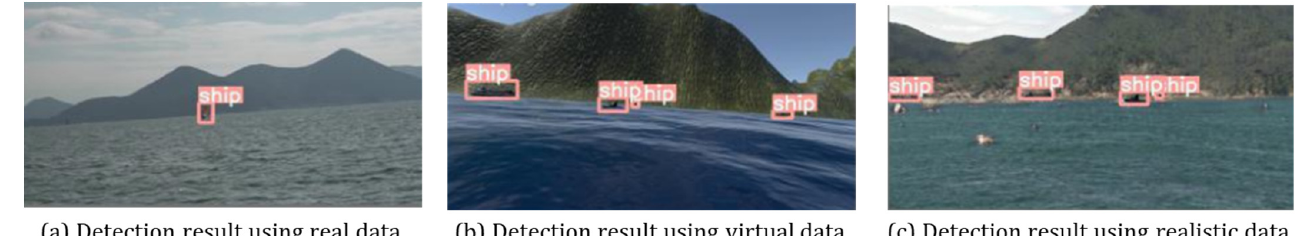
Figure 10. Ship detection results using three different data types: real, virtual and realistic.